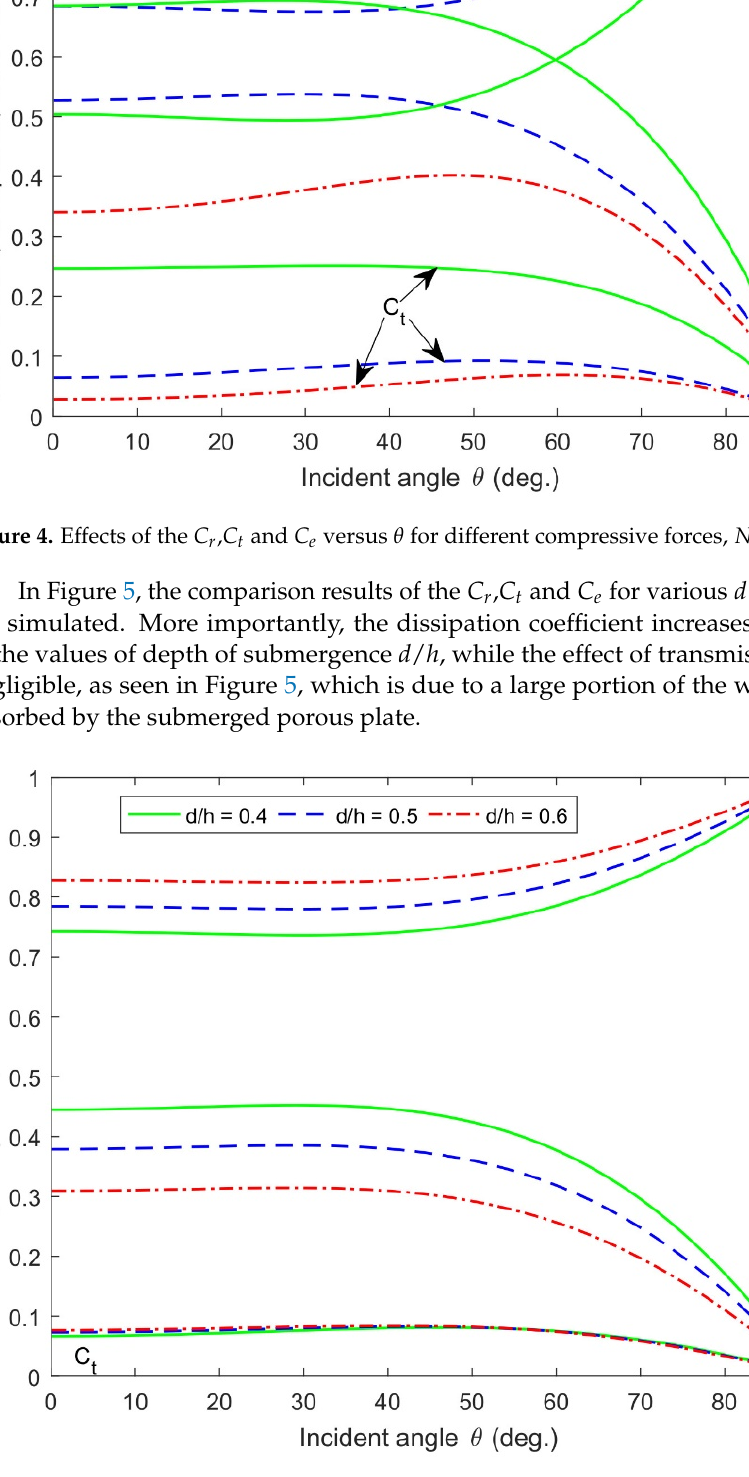
Figure 5. Effects of different d / h versus θ on C r , C t , and C e